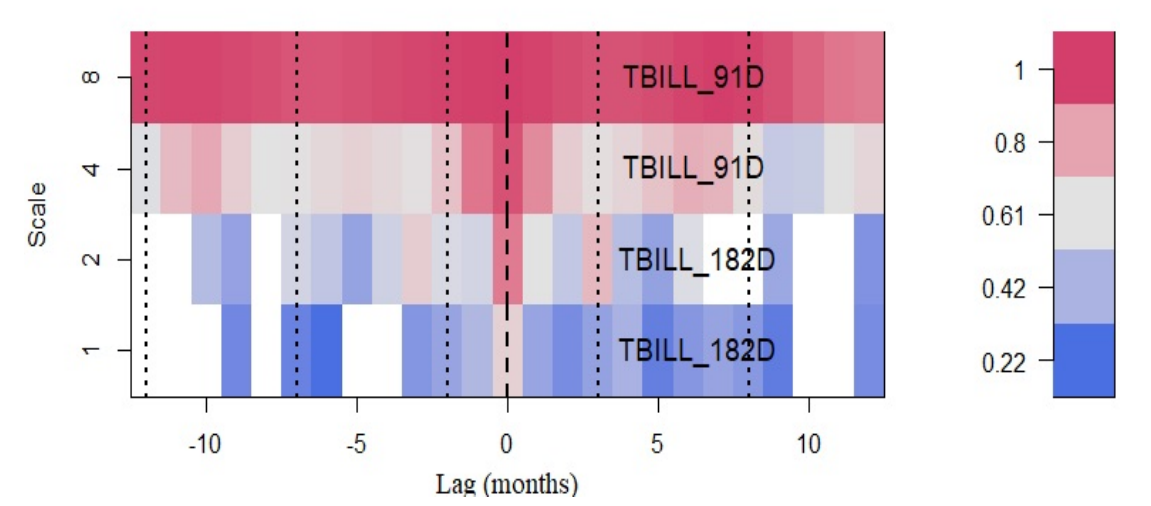
Figure 11. WMCC among the indicators of GSE and interest rates. Table 5. WMCC among the indicators of GSE and interest rates.